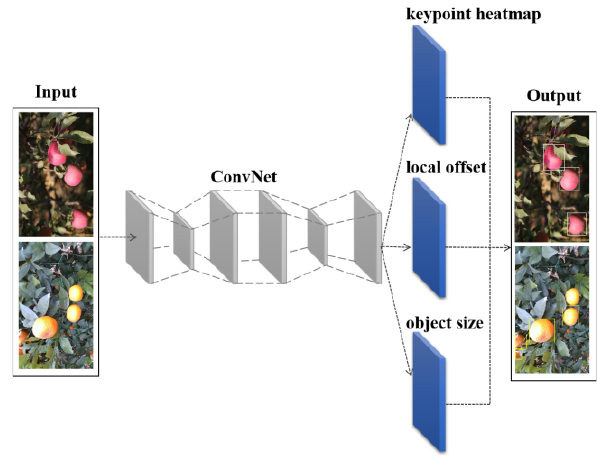
Figure 4. The network architecture of the CenterNet detector.